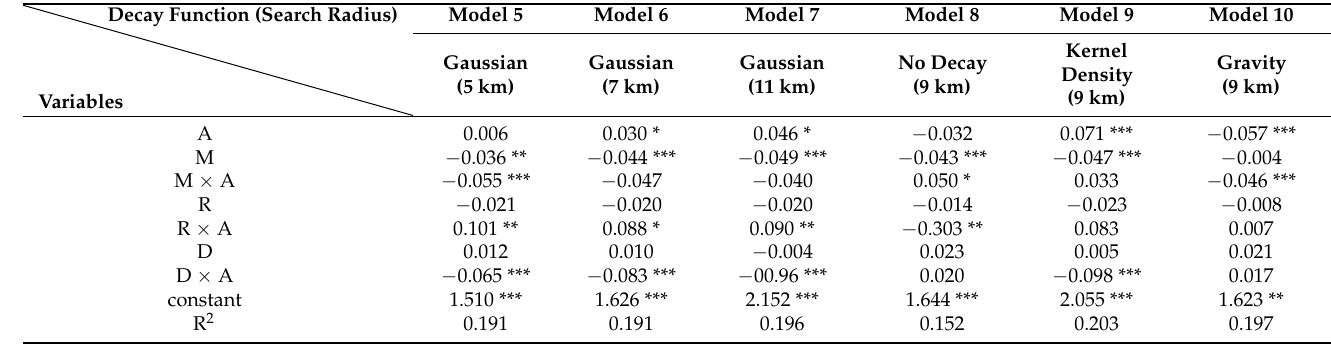
Table 4. Robustness test on the impact of job accessibility on occupancy